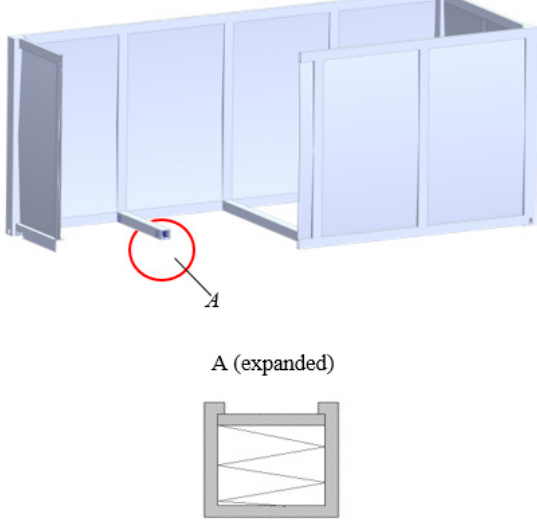
Figure 3. Location of elastic elements in the cross bearers of a container.